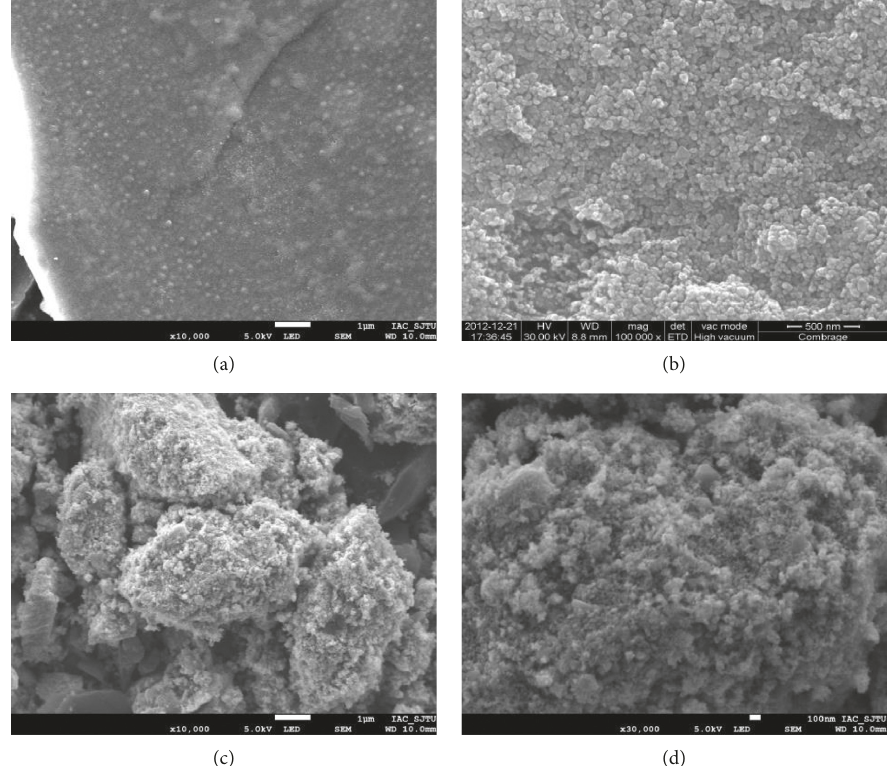
Figure 6: SEM images of (a) AC, (b) ZnFe 2 O 4 , (c) ZnFe 2 O 4 /AC at low magnification, and (d) ZnFe 2 O 4 /AC at high